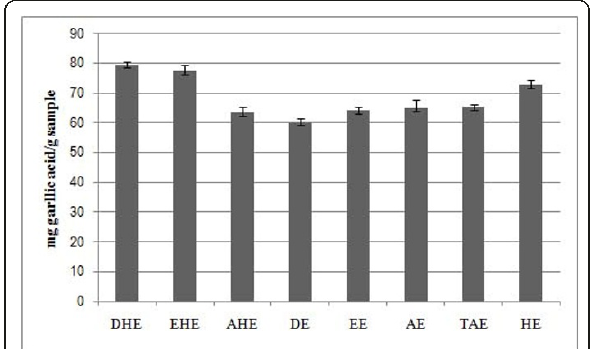
Figure 1 Total phenolic compounds of A. lappa extracts . DHE: dichloromethane hot extract; EHE: ethanolic hot extract; AHE: aqueous hot extract; DE: dichloromethane extract; EE: ethanolic